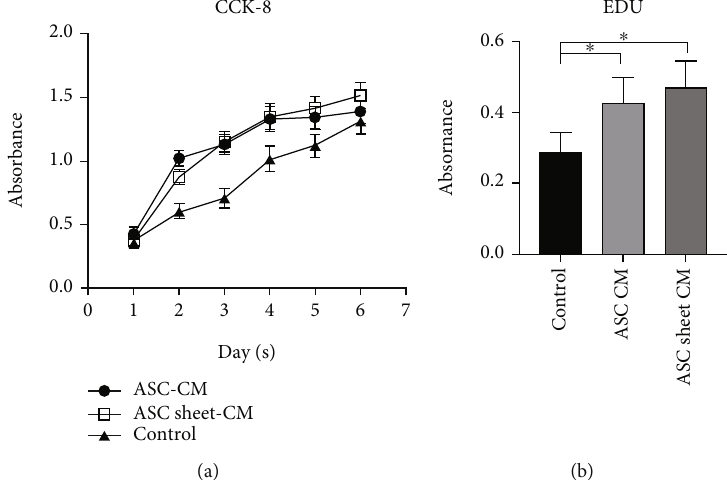
Figure 5: ASC-CM and ASC sheet-CM enhanced the proliferation of ECs. (a) The e ff ects of ASC-CM and ASC sheet-CM on the proliferation of ECs were evaluated by Cell Counting Kit-8 (CCK-8) assay ( n = 5 ). (b) The e ff ects of ASC-CM and ASC sheet-CM on the proliferation of ECs were evaluated by Edu assay at 72h. ∗ p < 0 : 05